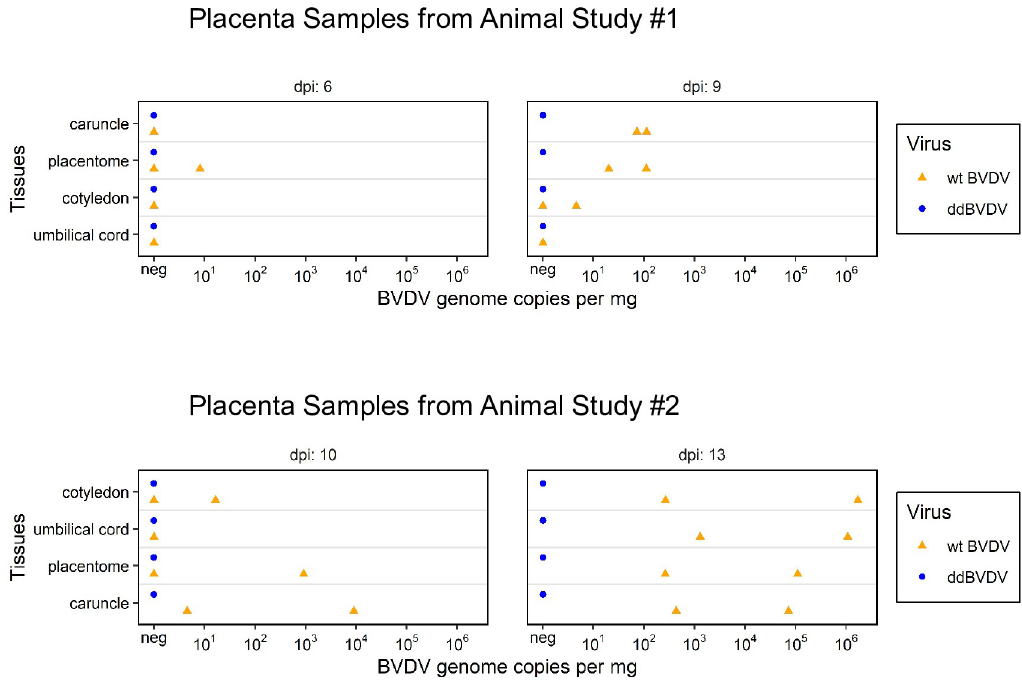
Fig 7. Detection of viral RNA in placenta samples. Orange triangles and blue dots stand for the animals infected with wt BVDV or ddBVDV, respectively. The positioning of the triangles and dots reflects the amount of viral RNA detected (in copies per mg total isolated